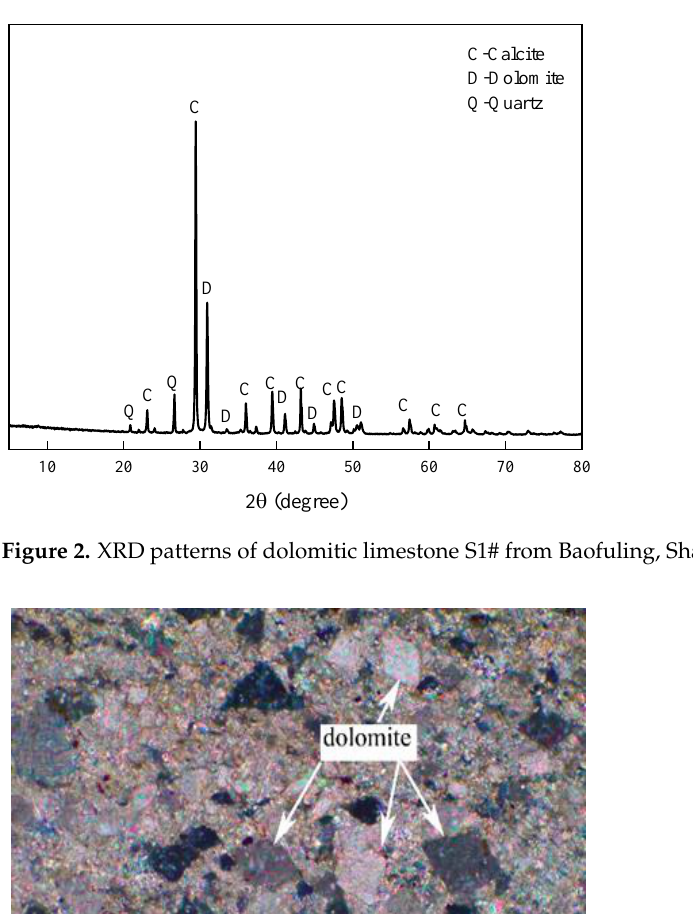
Table 2. Chemical composition of dolomitic limestone S1# (wt%).